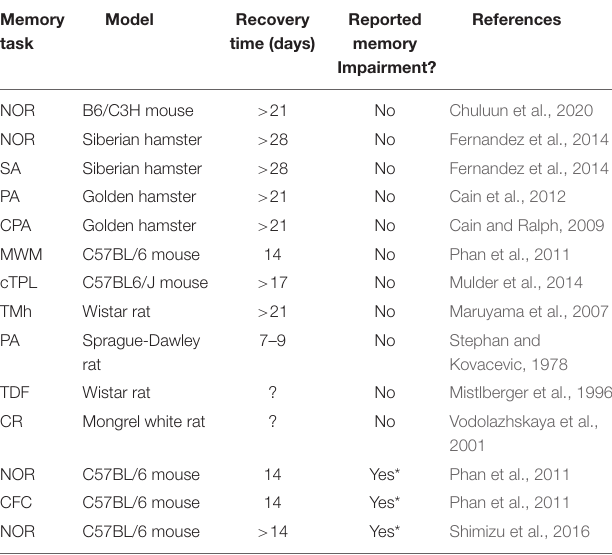
TABLE 1 | Memory tests performed in SCNx